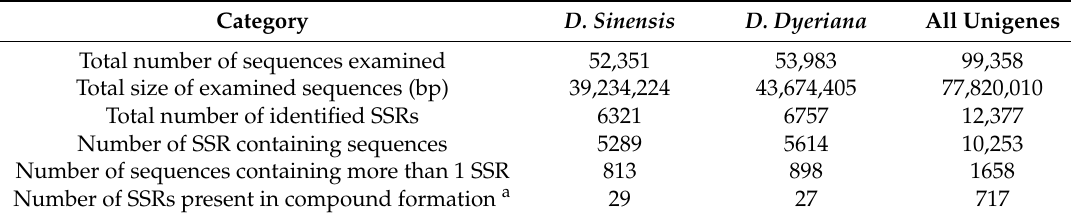
Table 3. Summary of the microsatellite identified in the transcriptome.